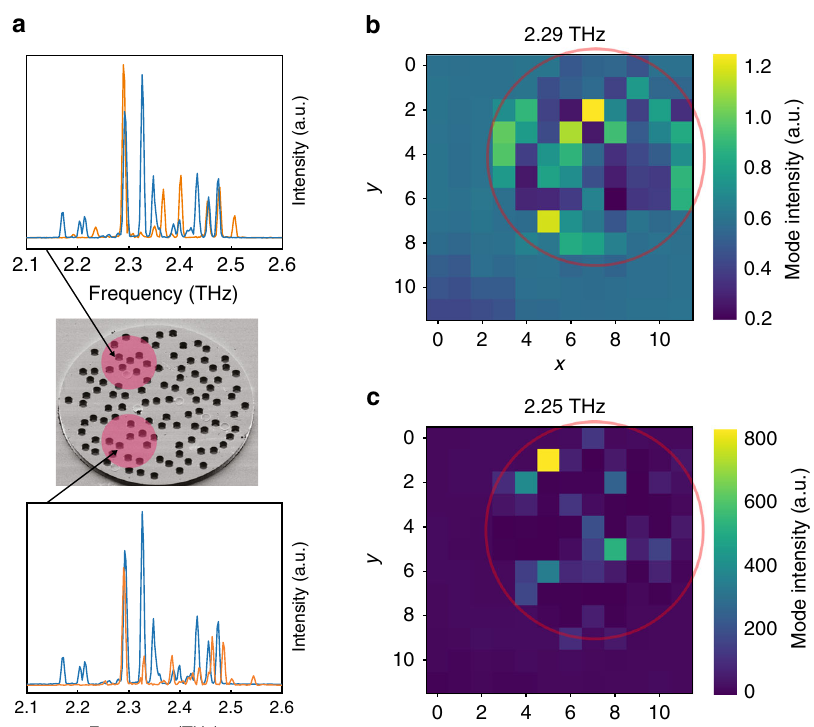
Fig. 3 Mode mapping through spot scanning. a The NIR spot is scanned across the device and the resulting spectra are measured. The two panels on the right-hand side display examples of spectra (orange curves) collected for the two indicated spot positions (the blue curves are measured without perturbation). b , c Mode intensity (measured as a ratio with the unperturbed case) of individual modes at 2.29 and 2.25 THz, respectively, while the spot is scanned across the QCRL. Each pixel in the displayed 12 × 12 matrices is associated with a spot location ( x , y ) (the red circles mark the QCRLs ’ outer